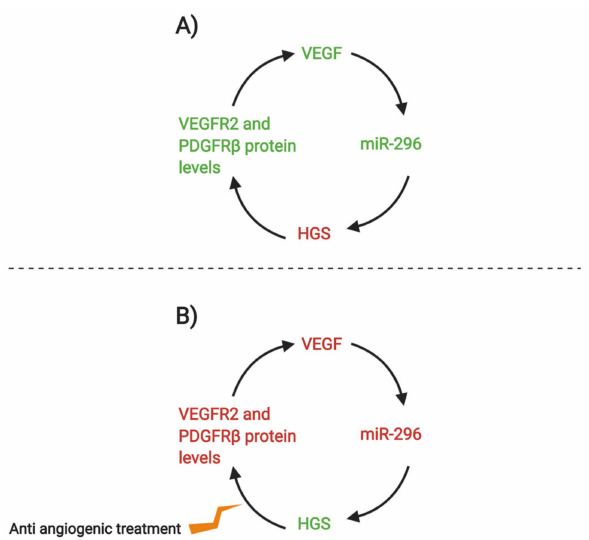
Figure 3. ( A ) Vascular endothelial growth factor (VEGF) stimulates non-coding miR-296, which then lowers the expression of platelet-derived growth factor (HGS). HGS is responsible for controlling the degradative sorting of VEGFR and platelet-derived growth factor receptor (PDGFR), so their protein expression levels are regulated. However, since miR-296 lowers HGS, then VEGF2 and PDGFR β levels increase, stimulating VEGF activity. ( B ) Anti-angiogenic treatment is used to downregulate the activity of VEGFR and PDGFR, which decreases their protein levels, which could combat the e ff ects of the miR-296 cycle [113]. (Created with